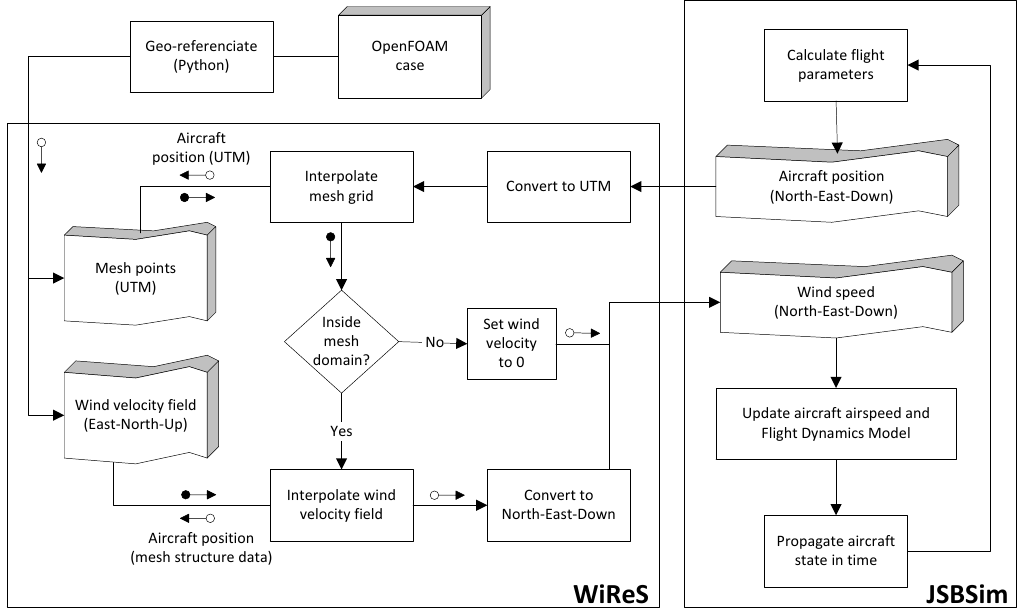
Figure 5. Block scheme representing the interaction among JSBSim, WiReS and